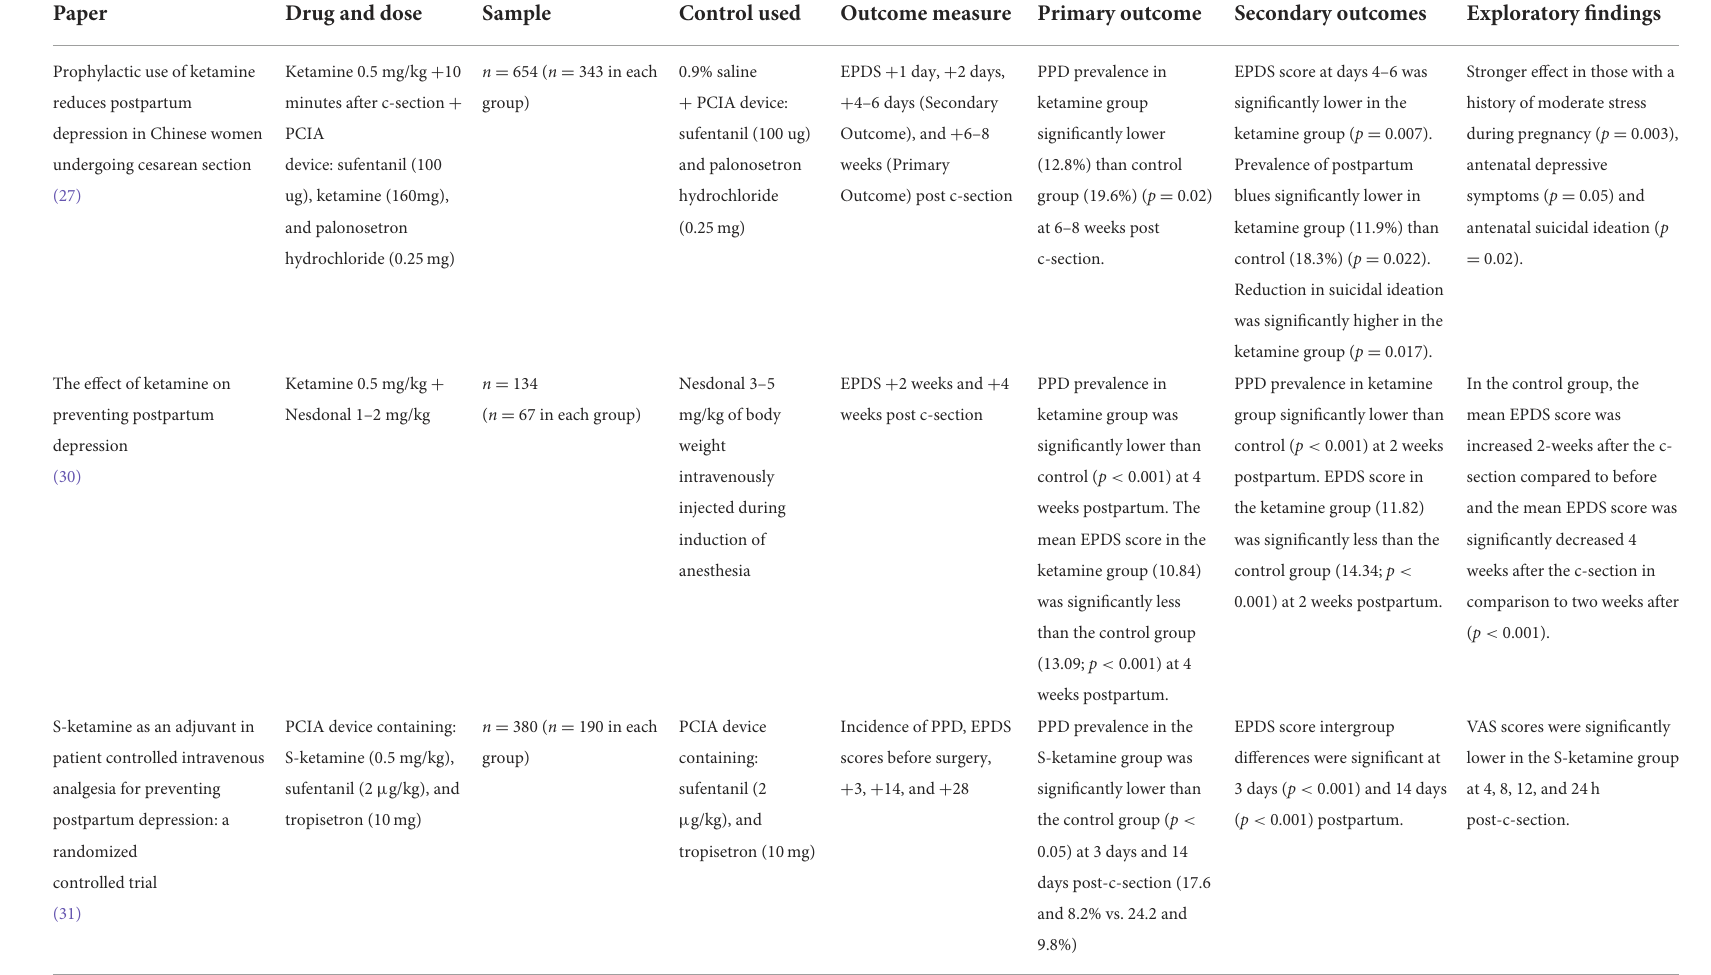
TABLE 2 Effect of ketamine on prevention postpartum depression